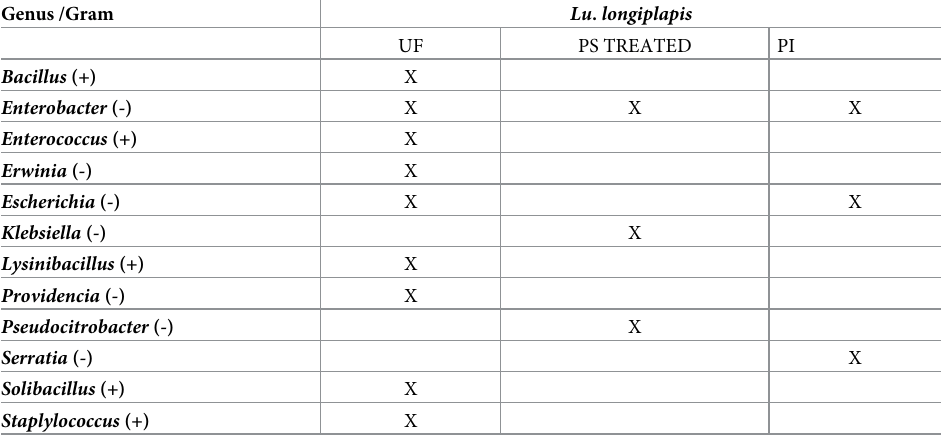
Table 2. Bacterial genera isolated from Lu . Longipalpis after treatment with PenStrep and post-infection with L . i . chagasi .